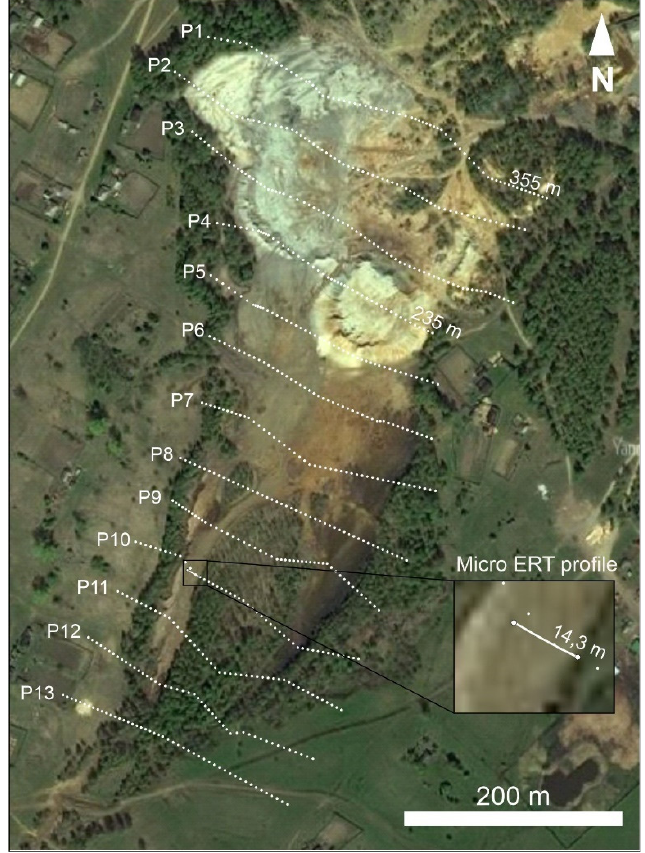
Figure 3. Configuration of ERT profiles.